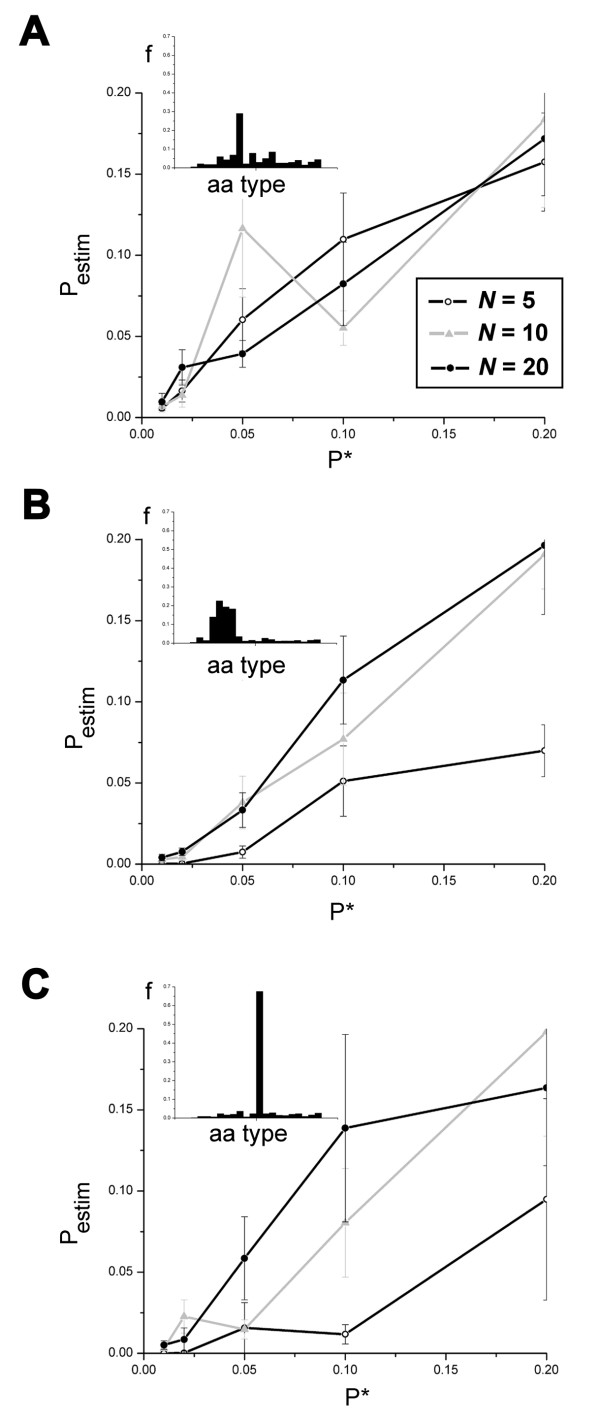
P-value estimates for comparison between alignment columns and residue frequency vectors: random simulations show general consistency with null model. (A-C) For different emission vectors based on real alignment columns, large sets of random columns of three different sizes N were generated, and P-value estimates by PEAC (Pestim) were plotted against experimentally estimated P-values (P*, see text for details). Sets of emission frequencies are shown as bar graphs in inserts.